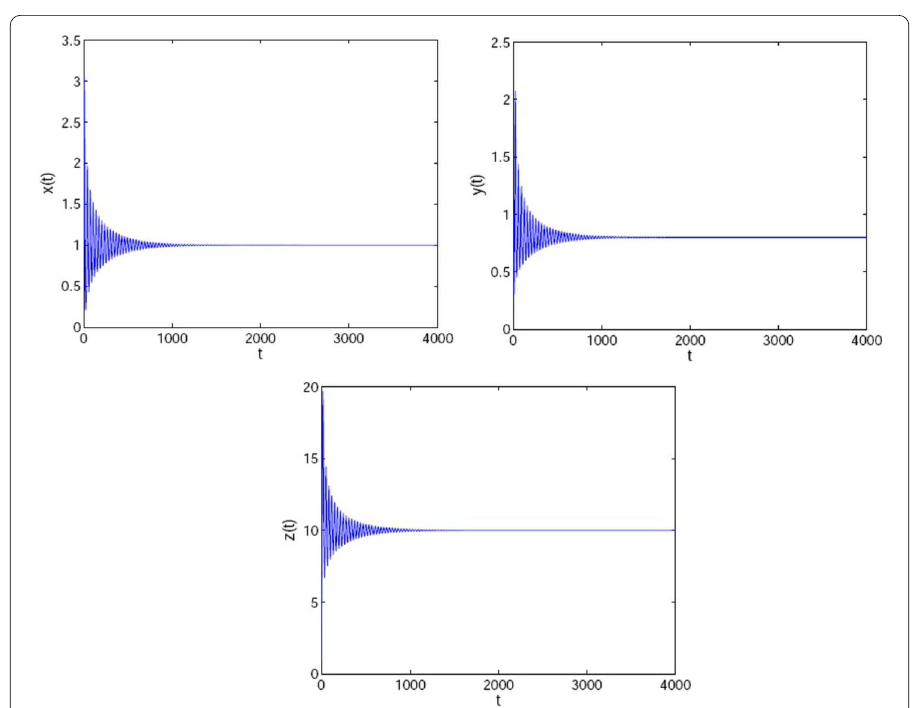
Figure 1 The equilibrium (1,0.8,10,10) of system (31) is asymptotically stable when τ = 6.6 < τ 0 = 6.834